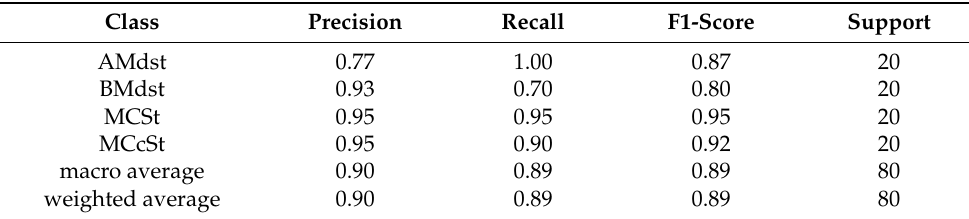
Table A4. Classification report for ResNet18—baseline. The overall accuracy is 0.89.